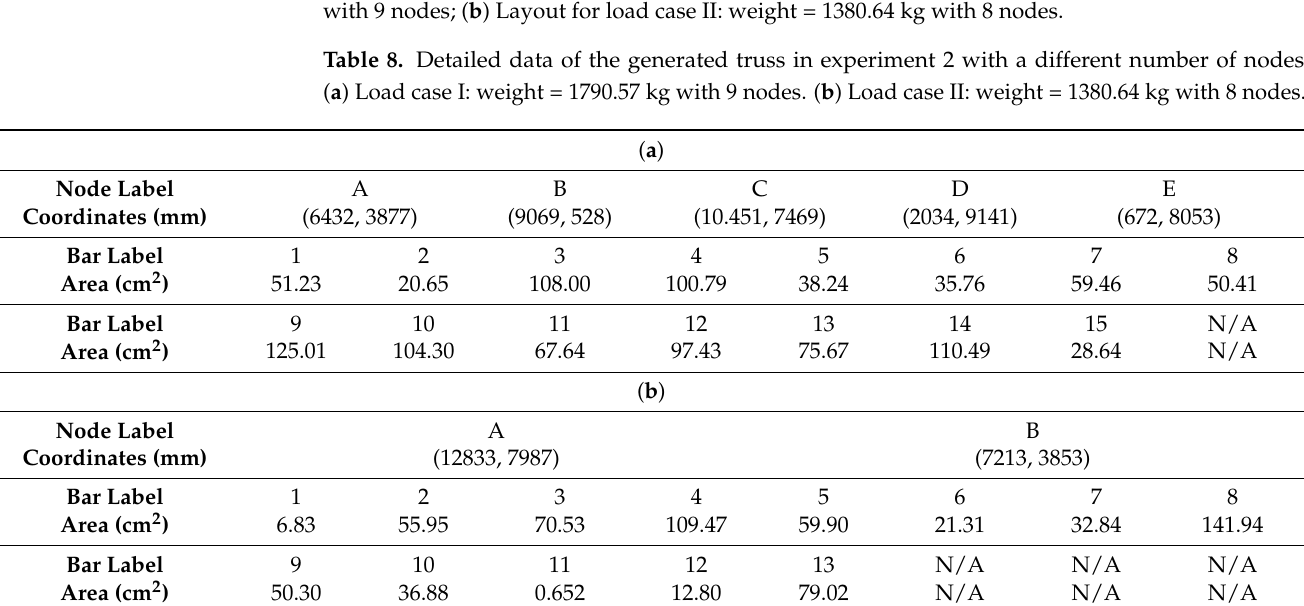
Figure 11. Generated trusses in experiment 2 with a different number of nodes, color red and blue denote the compression and tension bar, respectively. ( a ) Layout for load case I: weight = 1790.57 kg with 9 nodes; ( b ) Layout for load case II: weight = 1380.64 kg with 8 nodes.